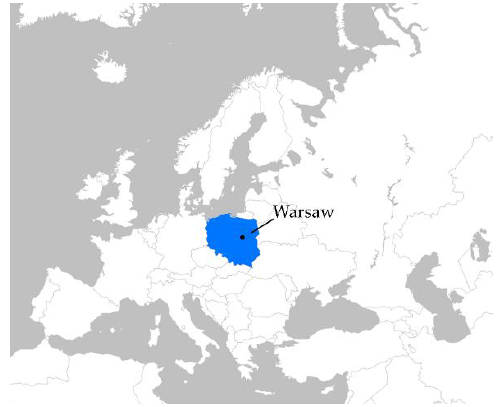
Figure 1. The territory of Poland and the location of Warsaw.